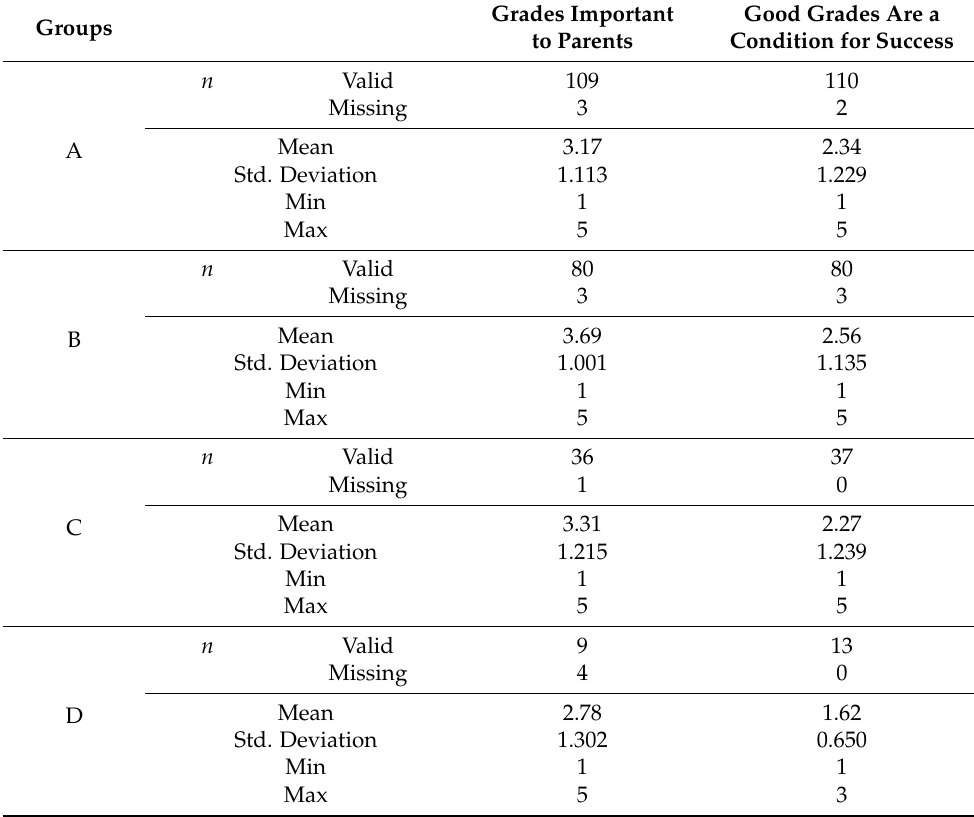
Table 1. Students’ attitude to academic